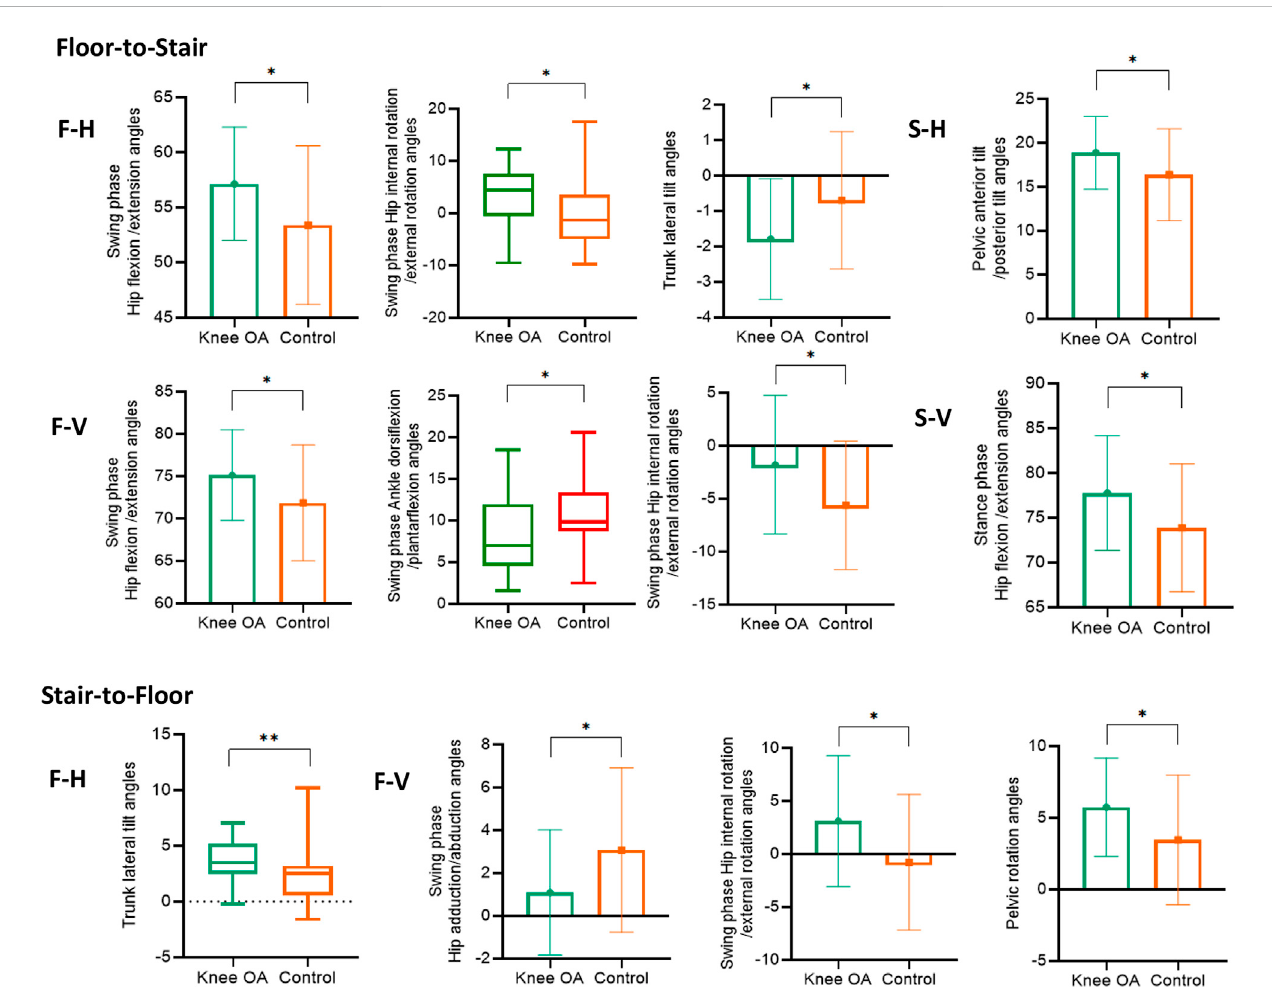
The signi fi cant differences in joint angles at FC moment in Floor-to-Stair and Stair-to-Floor